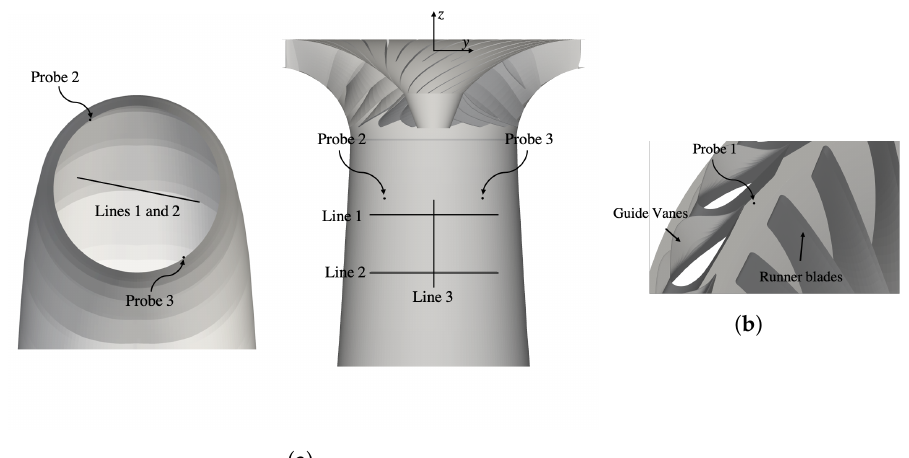
Figure 2. Measurement probes and lines in the experimental data provided by the second Francis-99 workshop. ( a ) Measurement probes and lines in the draft tube, ( b ) probe between guide vanes and